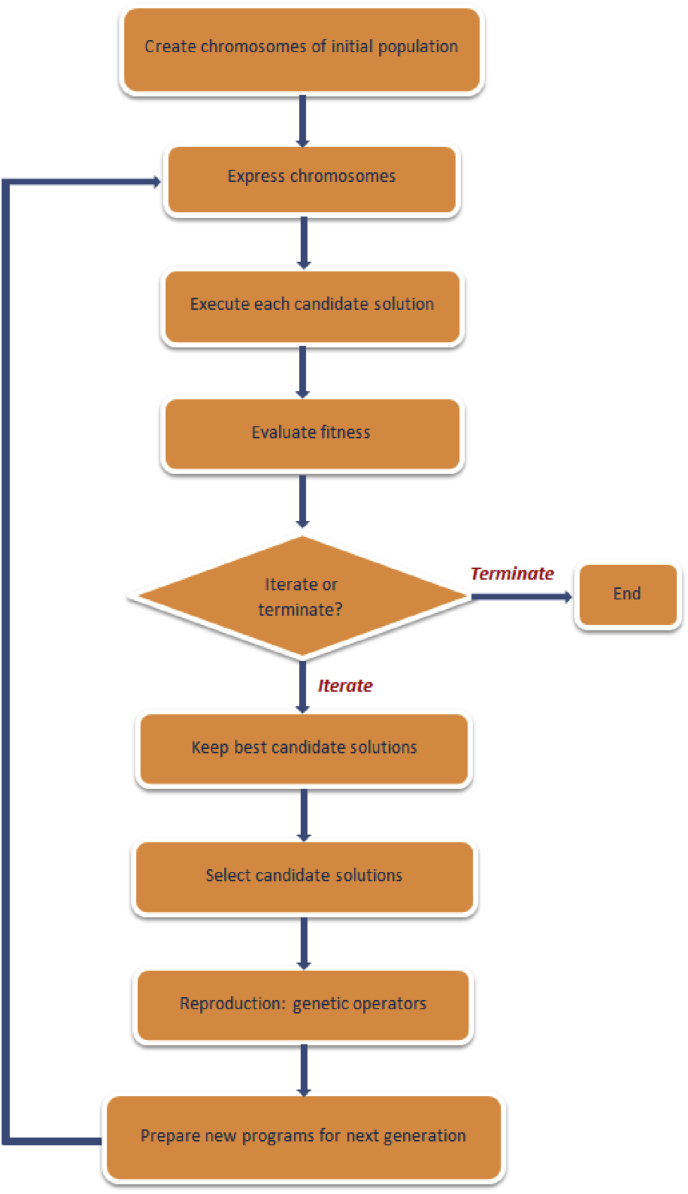
Steps in GEP implementation process [Adapted from Martí et al. (2013)].